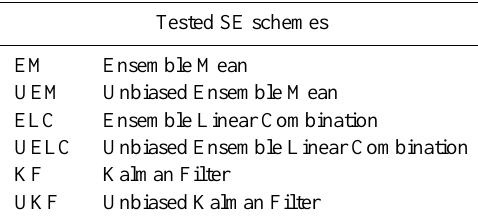
Table 2. Acronyms of the used SE